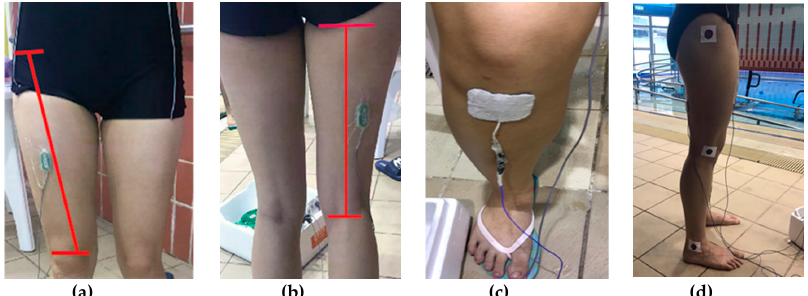
Figure 1. Location of the (a) RF electrode placement, (b) BF electrode placement, (c) ground electrode placement, (d) Three bony landmarks with markers attached.